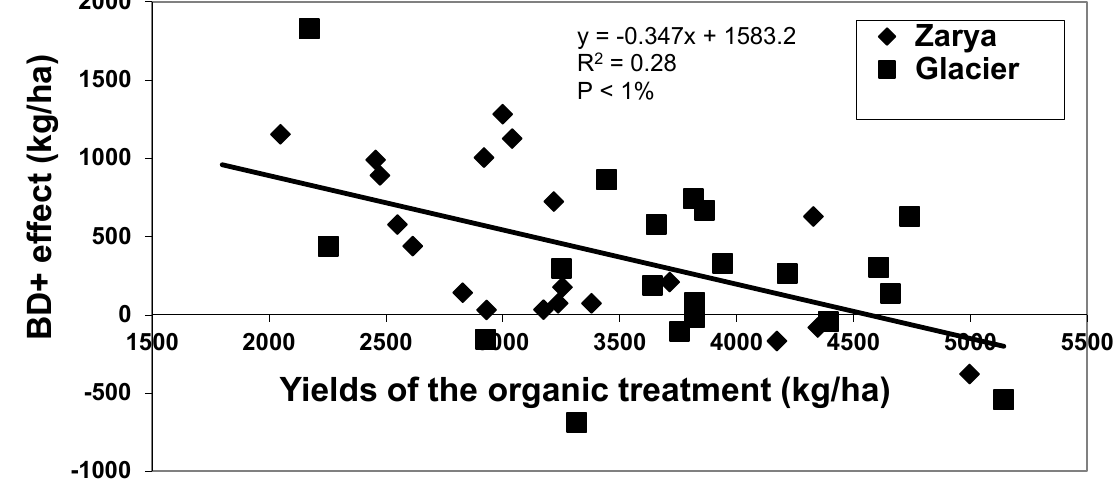
Figure 2: The effects of the BD+ treatment on the yields of winter wheat relative to the organic treatment